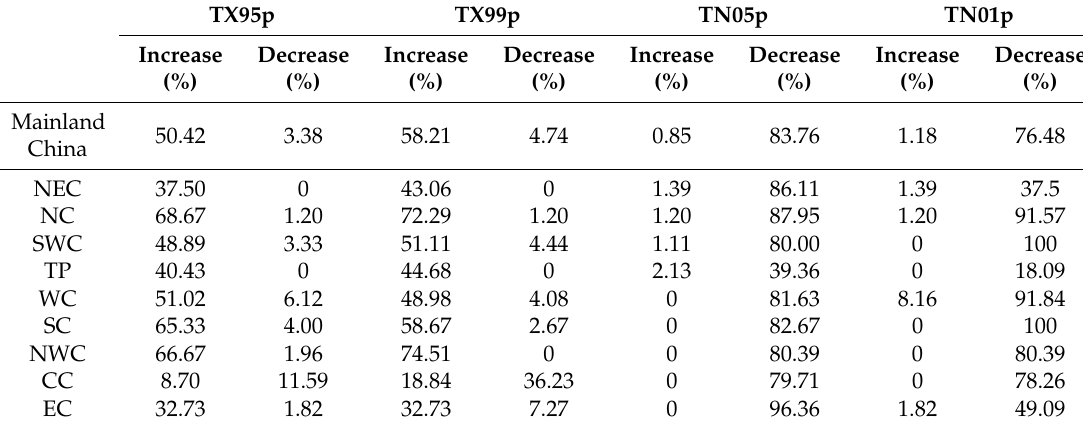
Table 2. Percentages of stations that passed the significance test ( p < 0.05) among the nine climate zones in mainland China. TX95p: warm days, TX99p: hot days, TN05p: cold nights, TN01p: very cold